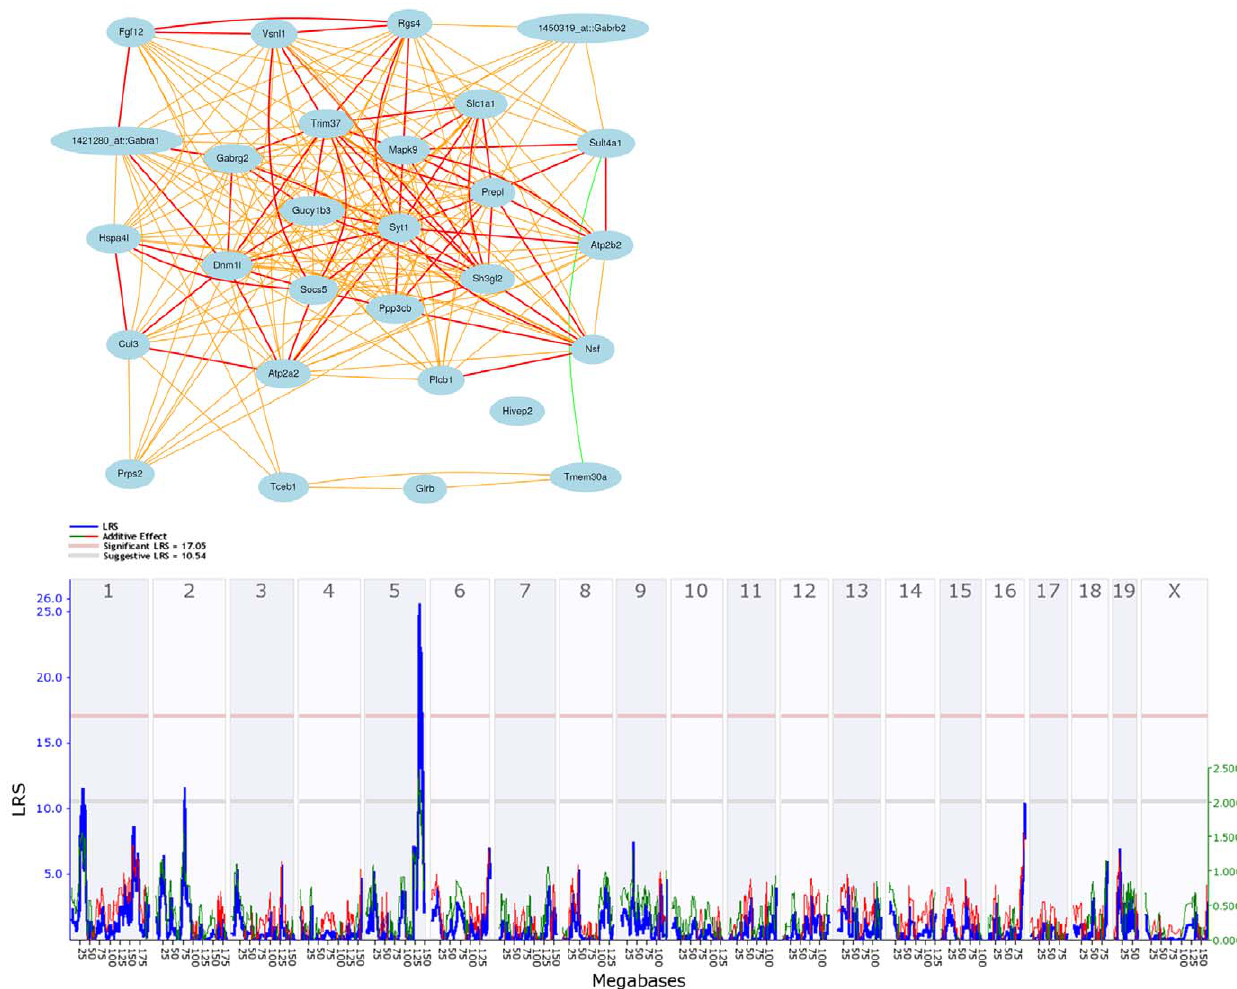
Figure 5. Conserved members of the GABA(A)R gene network. (A) Gabra1 , Gabrb2 , and Gabrg3 are generally well coexpressed across species and platforms. The set of highly conserved correlates include many synaptic genes such as Syt1 and Sh3gl2 . Bold lines indicate a correlation between 1 and 0.7 while normal and dashed lines indicate a correlation between 0.7 and 0.5 and 0.5 and 0.3, respectively. Warm colors represent positive correlations while cool colors represent negative correlations. (B) Expression of conserved module members is regulated by Trans5a . LRS score and additive effect are shown on the Y axis in blue and green, respectively. The blue line plots the strength of the association between gene expression and chromosomal location. The genome wide significant and suggestive threshold is shown by the red and grey horizontal line, respectively. Red and green lines show the effect of the D or B allele on trait values, respectively. The upper X-axis shows location by chromosome and the lower X-axis shows location in megabases.